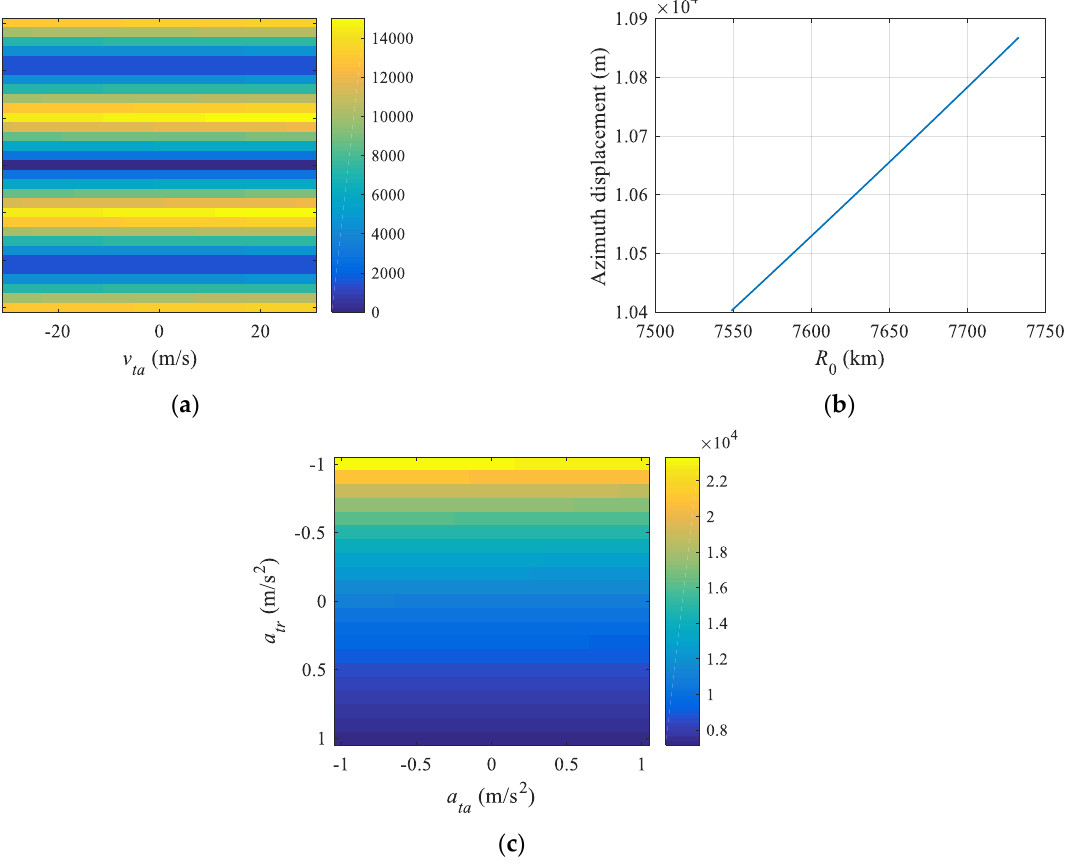
Figure 5. Dependences of the azimuth displacement on the target’s parameters. ( a ) a shift versus v tr and v ta , where a tr = 0.1 m/s 2 , a ta = 0.2 m/s 2 , R 0 = 7568.7 km; ( b ) a shift versus R 0 , the a tr = 0.1 m/s 2 , a ta = 0.2 m/s 2 , v tr = 7 m/s, v ta = 15 m/s; ( c ) a shift versus a tr and a ta , where v tr = 7 m/s, v ta = 15 m/s, R 0 = 7568.7 km .